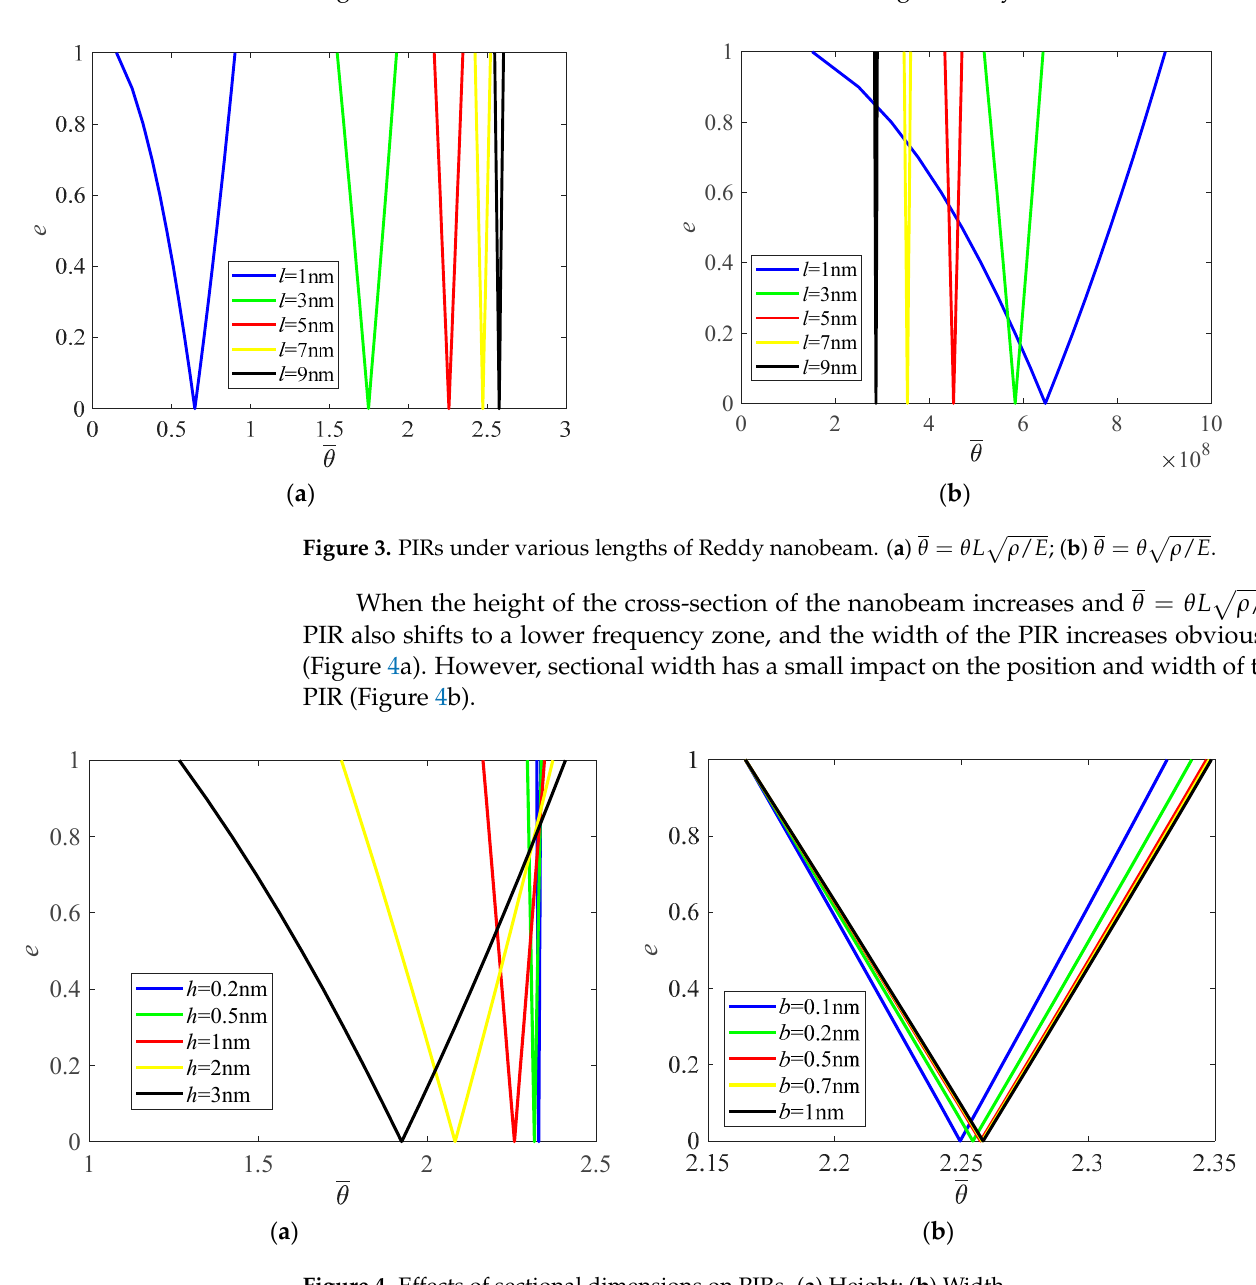
Figure 4. Effects of sectional dimensions on PIRs. ( a ) Height; ( b ) Width.